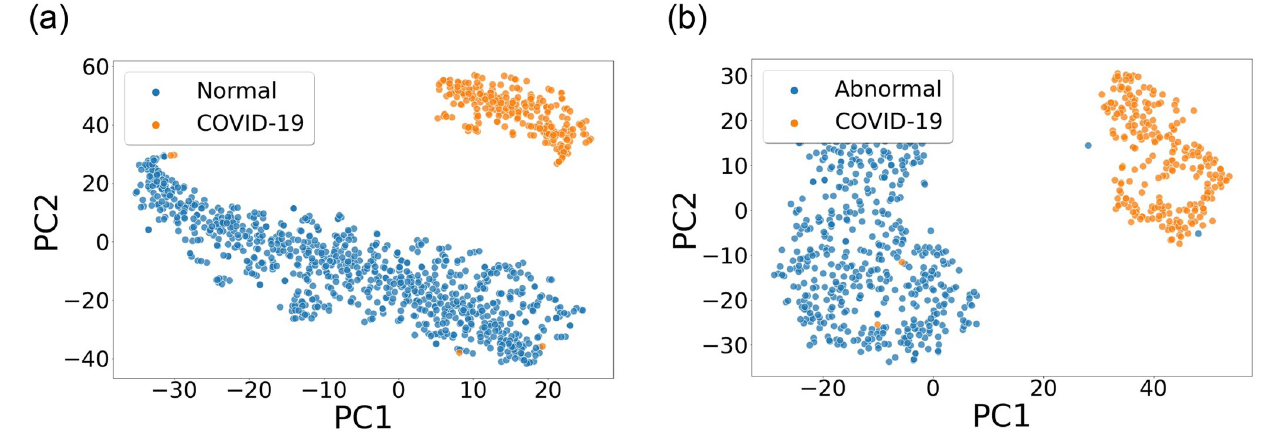
Fig 9. t-SNE plots of ECG data of different classes separated at the models’ last convolutional layer.